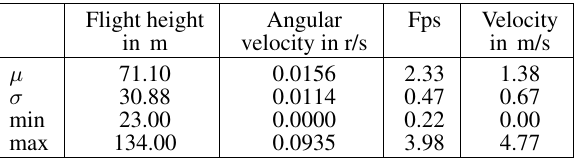
Table 1. Key information for our synthetic